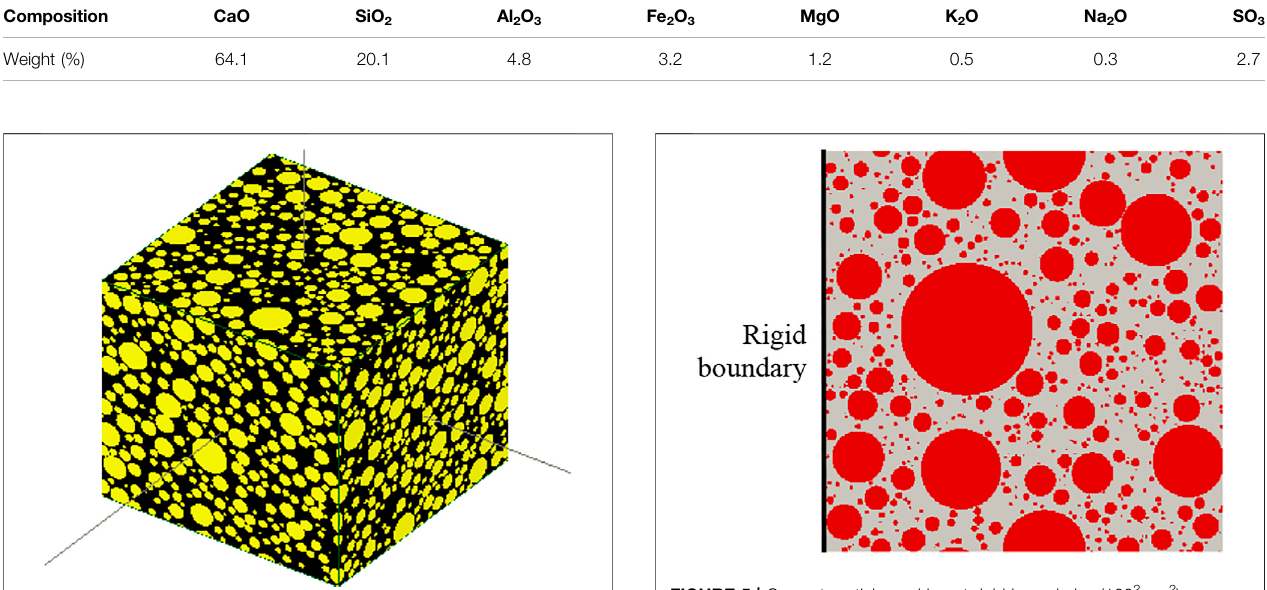
FIGURE 5 | Cement particle packing at rigid boundaries (100 2 μ m 2 ).